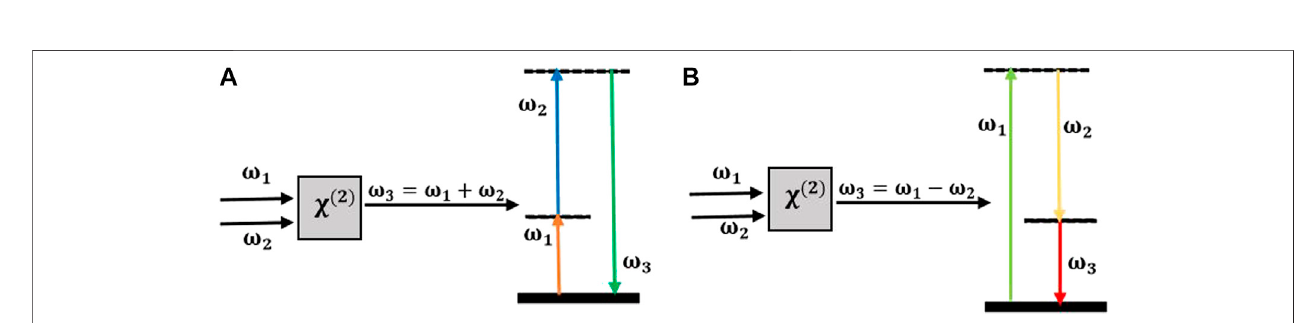
Figure 2 . Third-order NLO effects include third-harmonic